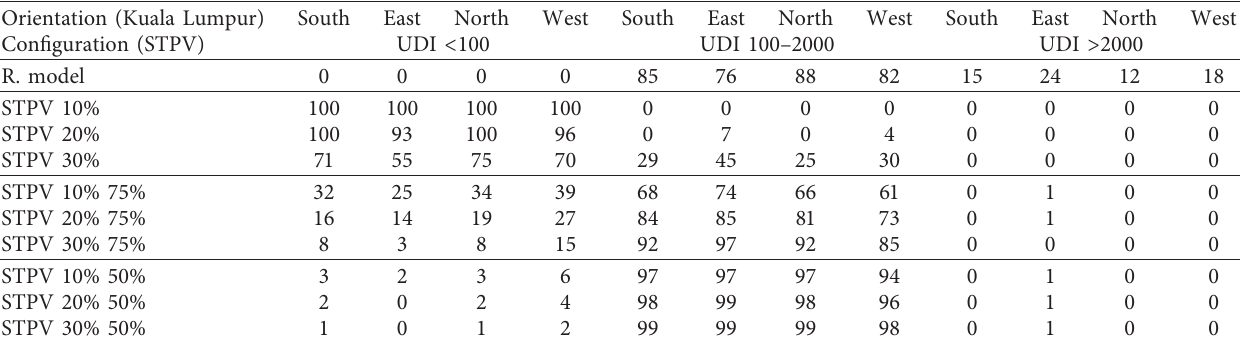
Table 15: UDI thresholds in cardinal orientations under intermediate sky condition (Kuala Lumpur city). Orientation (Kuala Lumpur)